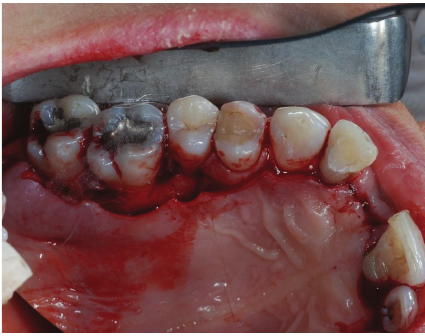
Figure 11: Surgical placement of the Bicon implant. The implant lies 1mm below the margin of the buccal bone dehiscence.